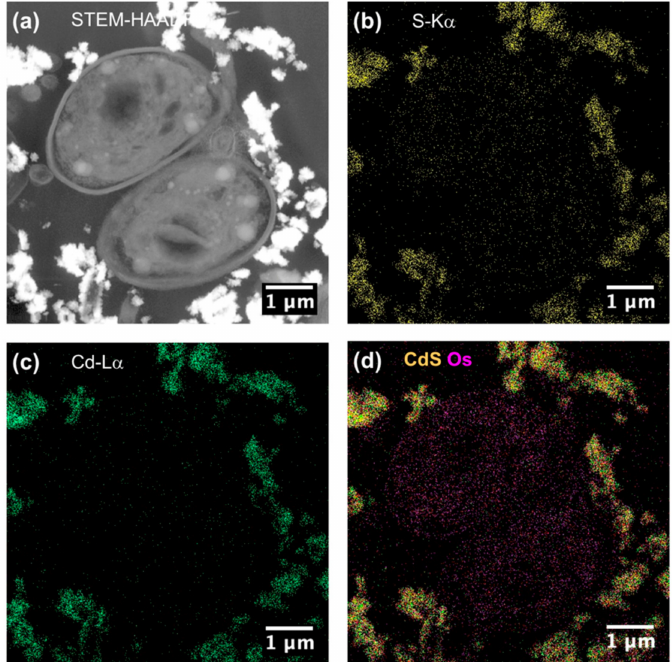
Figure 13. ( a ) STEM-HAADF and ( b – d ) STEM-XEDS images of Chlorella vulgaris ultrastructure after contact with CdS–2 nanoparticles (10 –2 M) in Seine